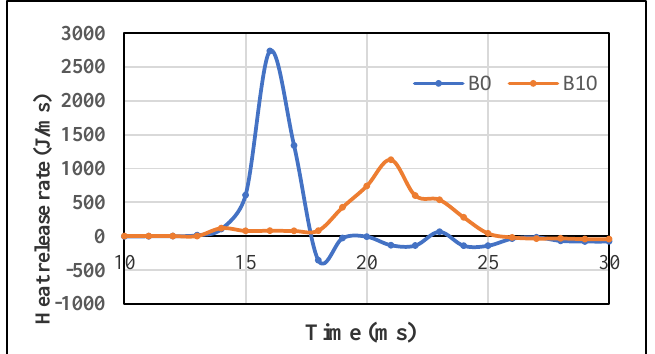
Figure 10. Heat release rate of fuel in CVCC.